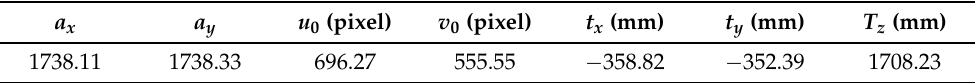
Table 2. IDLT results of the physical experiment.